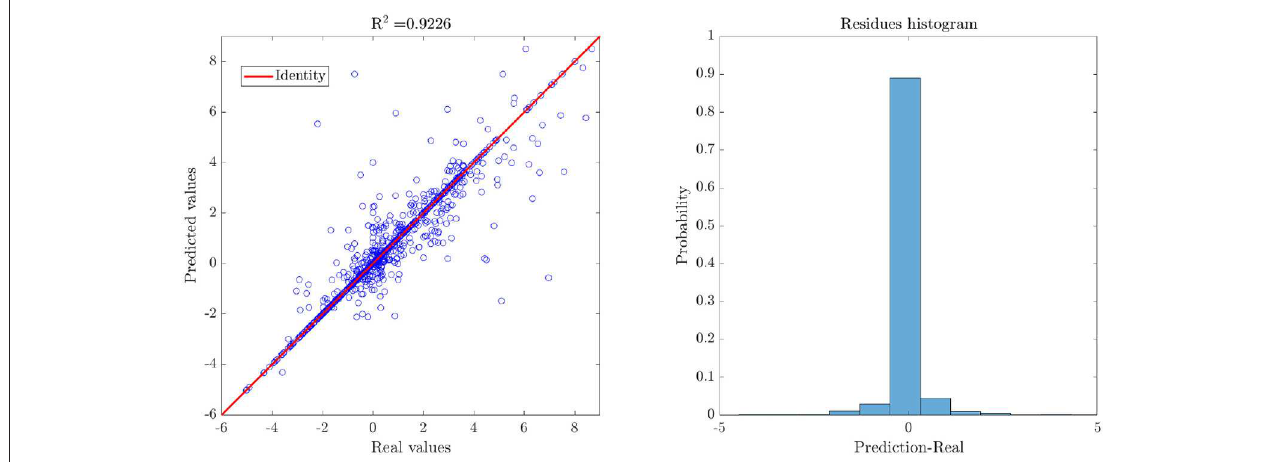
FIGURE 5 | Results of the generated weighted meta-model, where the predicted values are obtained from the average of the predictions of the individual methods. As the error seems to have a random distribution around zero, 11 G values predicted by the meta-model do not present considerable biases.